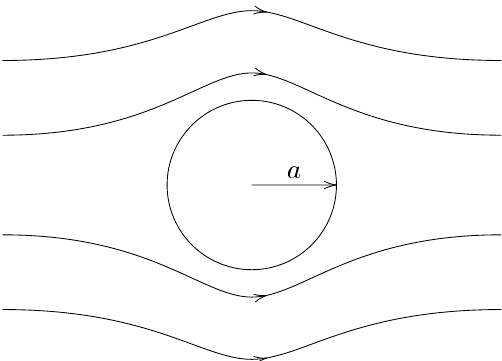
FIG. 9. Geometry for calculation of dipole current in a conducting cylinder immersed in a transverse magnetic field. The radius of the cylinder (representing the cathode stalk) is a .